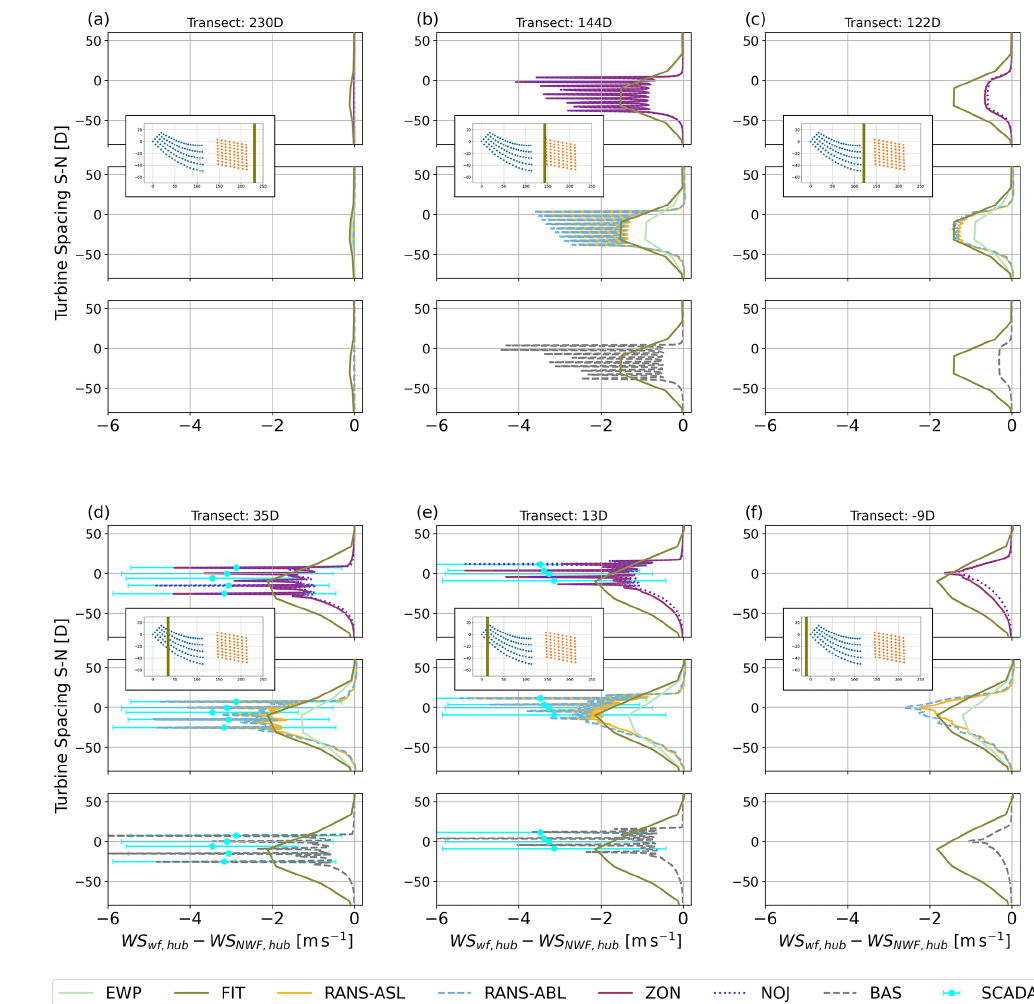
Figure 12. Wind speed transects at hub height for the different models in the north–south direction at different locations as indicated by the olive line in each subplot. The coordinates are relative to the coordinates of the easternmost turbine of Rødsand II and normalized with the rotor diameter of the Rødsand II turbine model SWT-2.3-93 (Table 1). All simulations are for NYRØ and normalized with a no-wind- farm (NWF) scenario. For abbreviations see Tables 5 and 7. WRF results and SCADA data are filtered according to the f1 method (Table 6). FIT and, if applicable, SCADA data are shown in each subplot to facilitate comparison of the different